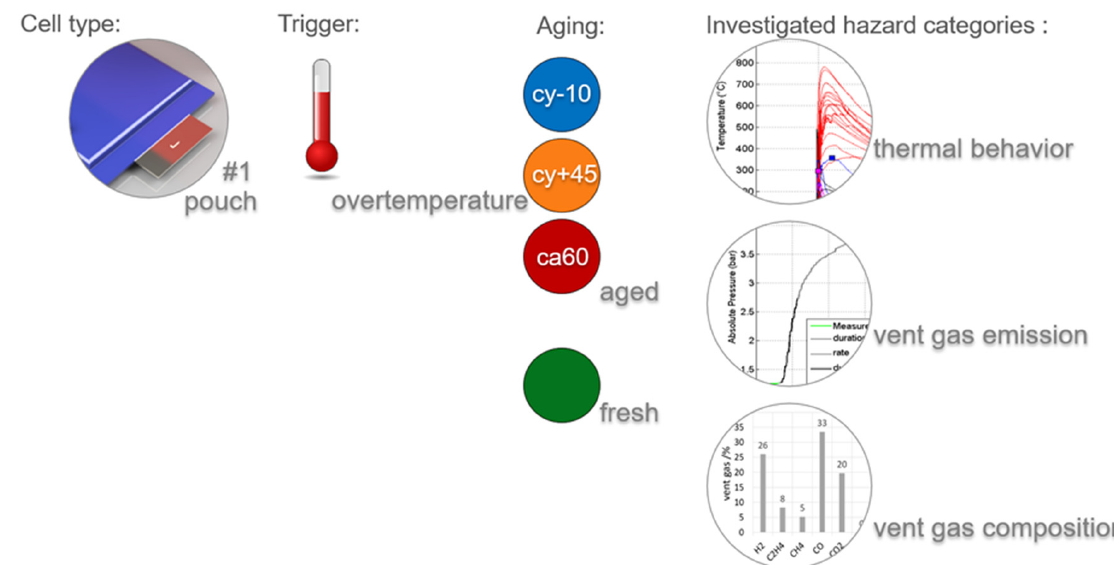
Figure 1. Design of experiment—Influence of different aging paths on the failing behavior of cell type #1. Three different aging paths were investigated (cyclic aging at − 10 °C (cy − 10) and at 45 °C (cy+45) and calendric aging at 60 °C (ca60)) and compared with the results of fresh cells. The results were discussed in three main hazard categories: thermal behavior, vent gas emission, and vent gas composition. Each cell was charged to 100% SOC and was tested using overtemperature trigger.